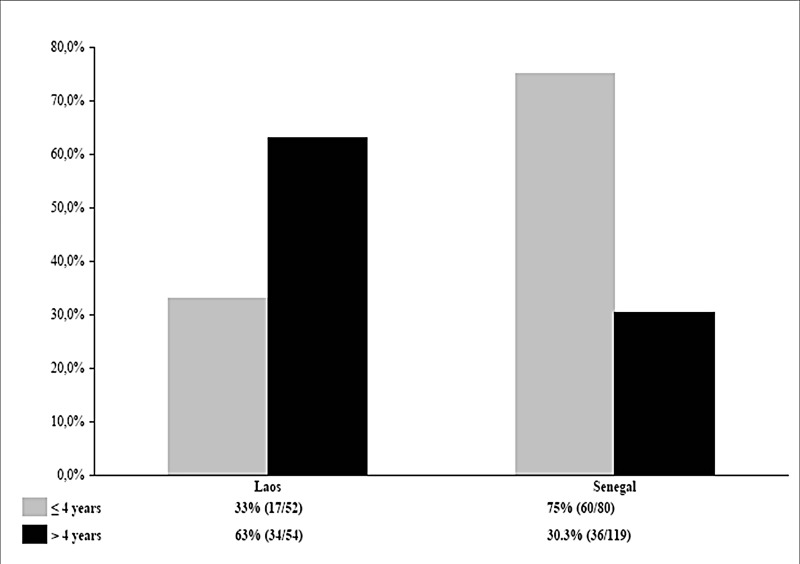
Comparisons of the prevalence of T. whipplei carriage in children feces between Senegal and Laos.